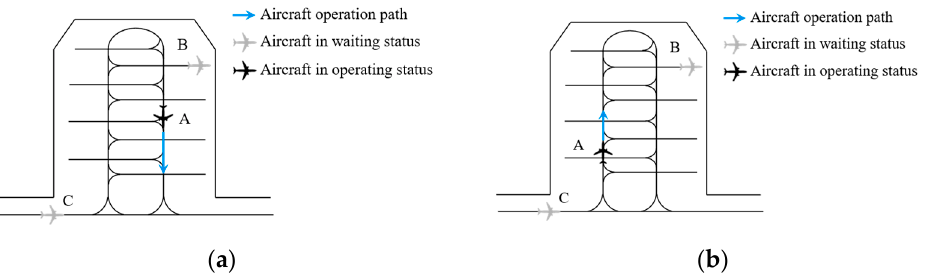
Figure 2. Exclusive Operation Procedure. ( a ) Departure: the departing aircraft A in the U-shaped area is pushing out, and the arrival air-craft C must wait outside the U-shaped area and the following departing aircraft B must wait in the stand until aircraft A leaves the U-shaped area; ( b ) Arrival: departing aircraft B within the U-shaped area must queue up in order to await push-back instructions and arrival aircraft C must wait outside the U-shaped area until aircraft A parks on stand.